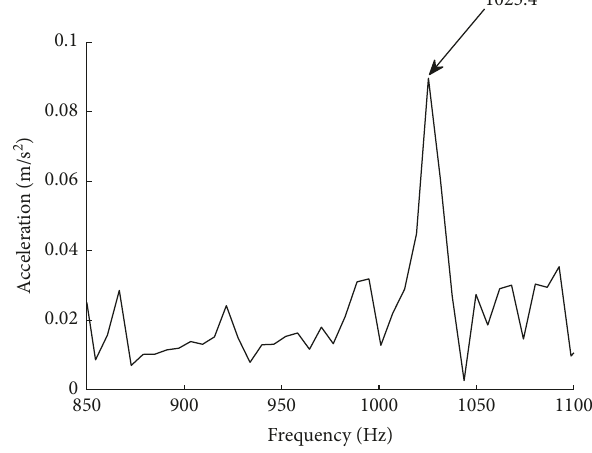
Figure 12: The acceleration-response spectrum corresponding to effective tension (cid:31)